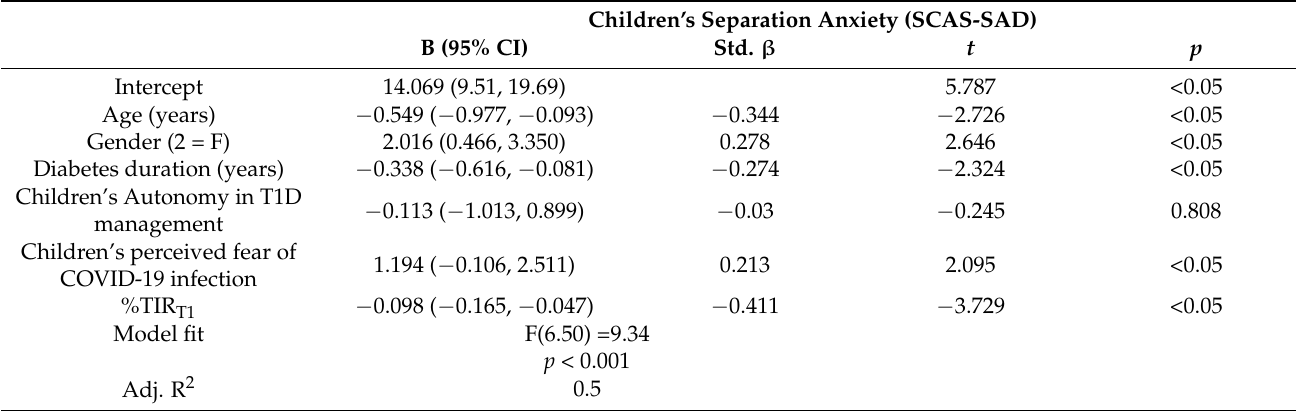
Table 4. Multiple regression of children’s separation anxiety (SCAS-SAD), (%TIR T1 , percentage of time in target range (70–180 mg/dL) at T 1